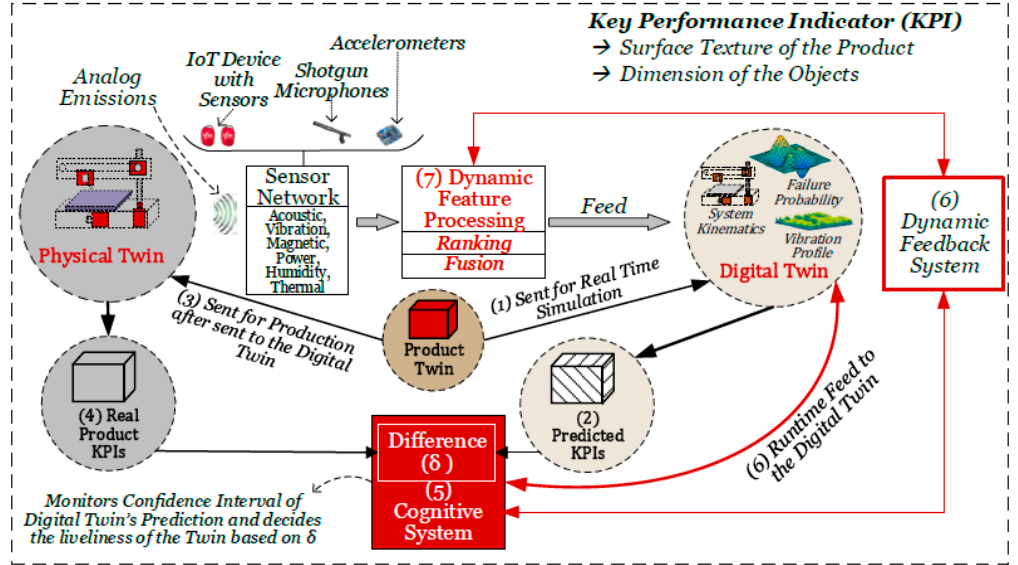
Figure 3. Dynamic data-driven application systems enabled digital twin of additive manufacturing cyber-physical system [20].